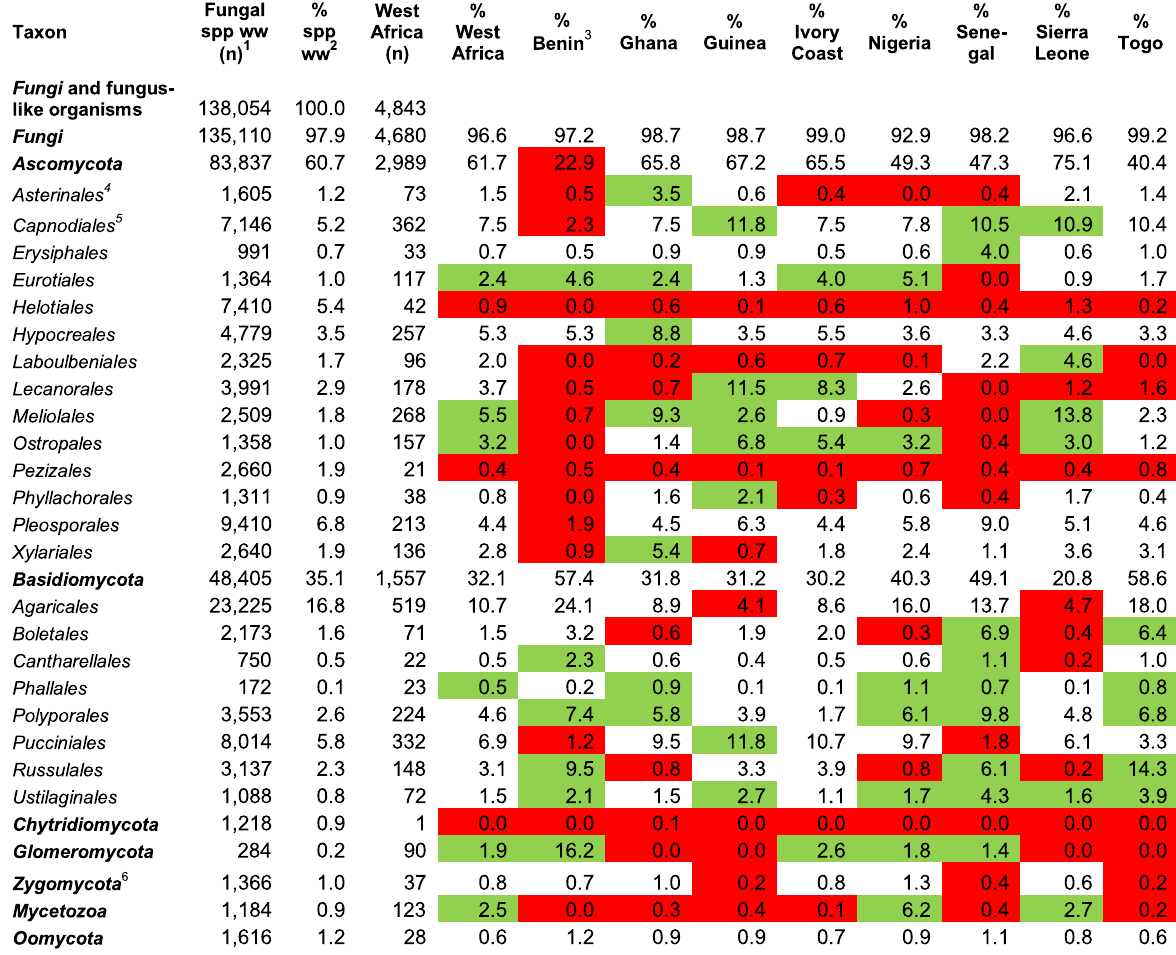
Table 2 Relatively well known (green) or underexplored (red) systematic groups of fungi in West Africa and West African countries (with at least 200 species known). Numbers highlighted by green indicate groups that present more than double percentage value in comparison to the value worldwide, those highlighted by red indicate understudied groups with less than half of the percentage value in comparison to the value